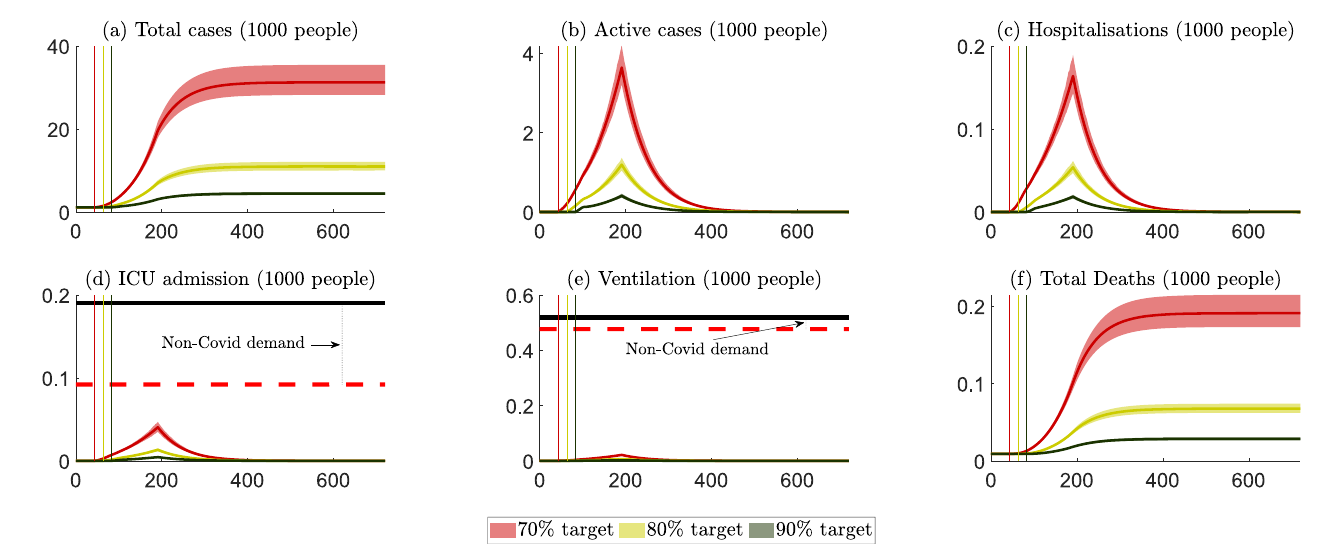
Fig 6. WA: Projected public health outcomes after opening up. Notes about Fig 6: 1. Day zero is specified to be October 11, 2021. 2. The red, yellow, and green colours represent scenarios where WA border is opened after the 70%, 80% and 90% targets, respectively. 3. The (red, yellow, and green) vertical lines represent the days when the 70%, 80% and 90% targets are reached. 4. The (red, yellow, and green) curves represent the mean of all projection outcomes, and the bands represent their 95% confidence intervals. 5. The black horizontal lines in panels (d) and (e) are the capacity of the health care system, i.e., staffed ICU beds and ventilators (data sources reported in S1 Text). 6. The red horizontal dashed lines in panels (d) and (e) are the net capacity of the non-covid demand for ICU and ventilation, which are estimated via the occupation rates of ICU beds and ventilators in 2018–2019 (data sources reported in S1 Text).